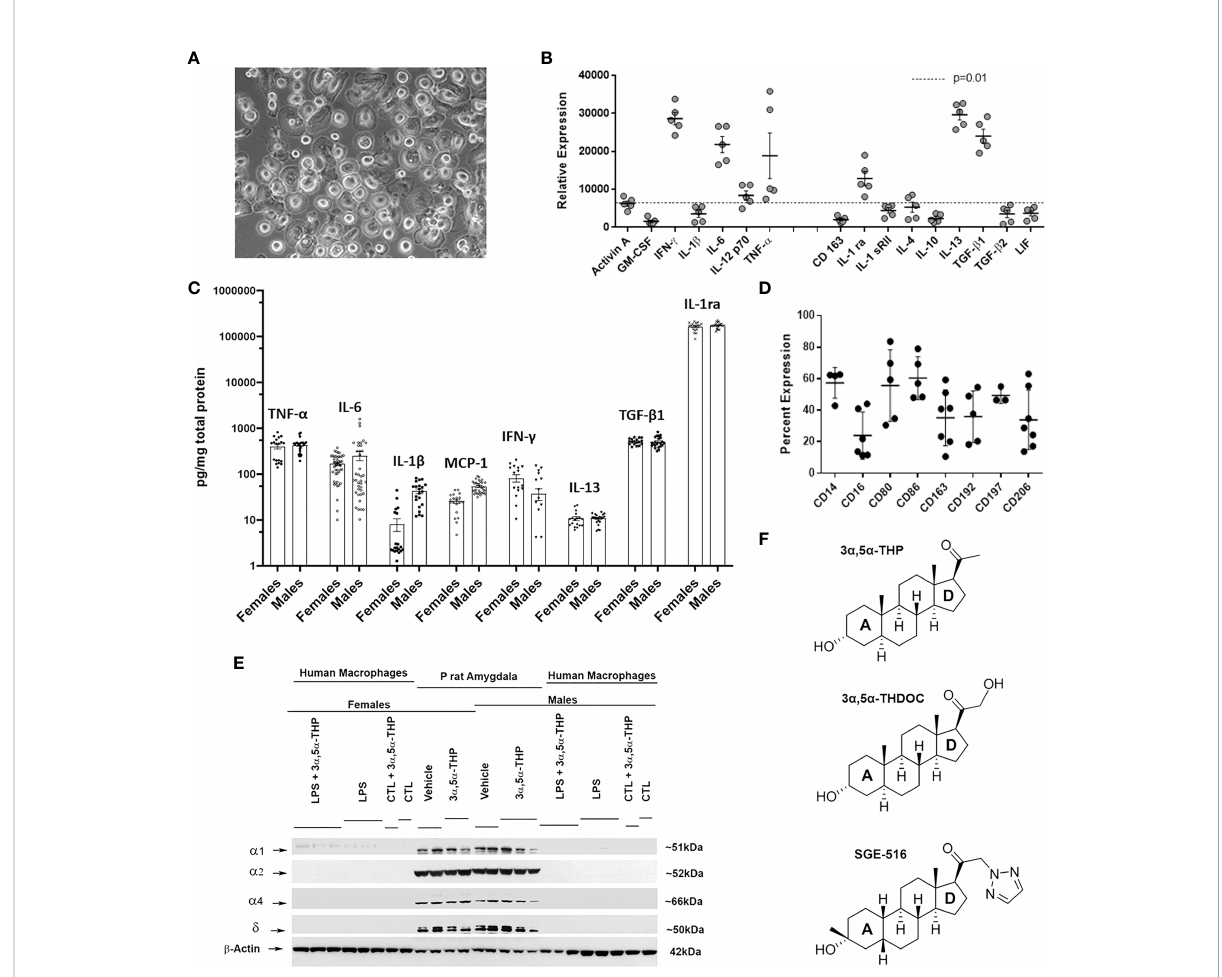
FIGURE 1 Characteristics of cultured human monocyte-derived macrophages. (A) Example of a monolayer of human monocyte-derived macrophages (hMDM) grown on ultralow adhesion plastic. (B) Basal hMDM secretome from 5 independent mixed sex cultures detected by RayBiotech human antibody array L-507 illustrating a mixed in fl ammatory and anti-in fl ammatory cytokine pro fi le. (C) hMDM cell lysates analyzed by ELISA express both in fl ammatory (TNF- a , IL-6, IL-1 b , MCP-1, IFN- g ) and anti-in fl ammatory (IL-13, TGF- b 1, IL-1ra) mediators with no evidence of sex differences at baseline. Each hMDM culture is shown as a single symbol (n ≥ 18), obtained from at least 3 male or 3 female donors. (D) hMDM surface markers determined by fl ow cytometry using direct immuno fl uorescence in 4-7 independent mixed sex cultures. (E) Western blot image shows that hMDM from both male and female donors (n=9 cultures from 3 donors/sex) lack g -aminobutyric acid type A (GABA A ) receptor subunits a 1, a 2, a 4, and d at baseline (CTL) or after treatments with lipopolysaccharide (LPS) and/or allopregnanolone (3 a ,5 a -THP). As a positive control, the amygdala from male and female alcohol preferring P rats intraperitoneally injected with vehicle (45% w/v 2-hydroxypropyl- b - cyclodextrin; 30 min) or allopregnanolone (15 mg/kg; 30 min) was used. (F) Chemical structures of endogenous neurosteroids allopregnanolone and 3 a ,5 a -THDOC (tetrahydrodeoxycorticosterone) and the synthetic 1,2,5-triazole analog of the allopregnanolone, SGE-516. 3 a ,5 a -THDOC differs from the allopregnanolone by a C-21-hydroxyl group at the D-ring. SGE-516 differs from the allopregnanolone by a C-3 cis-methyl and cis-hydrogens at C-5 and C-19, and a C-21-1,2,5-triazole group at the